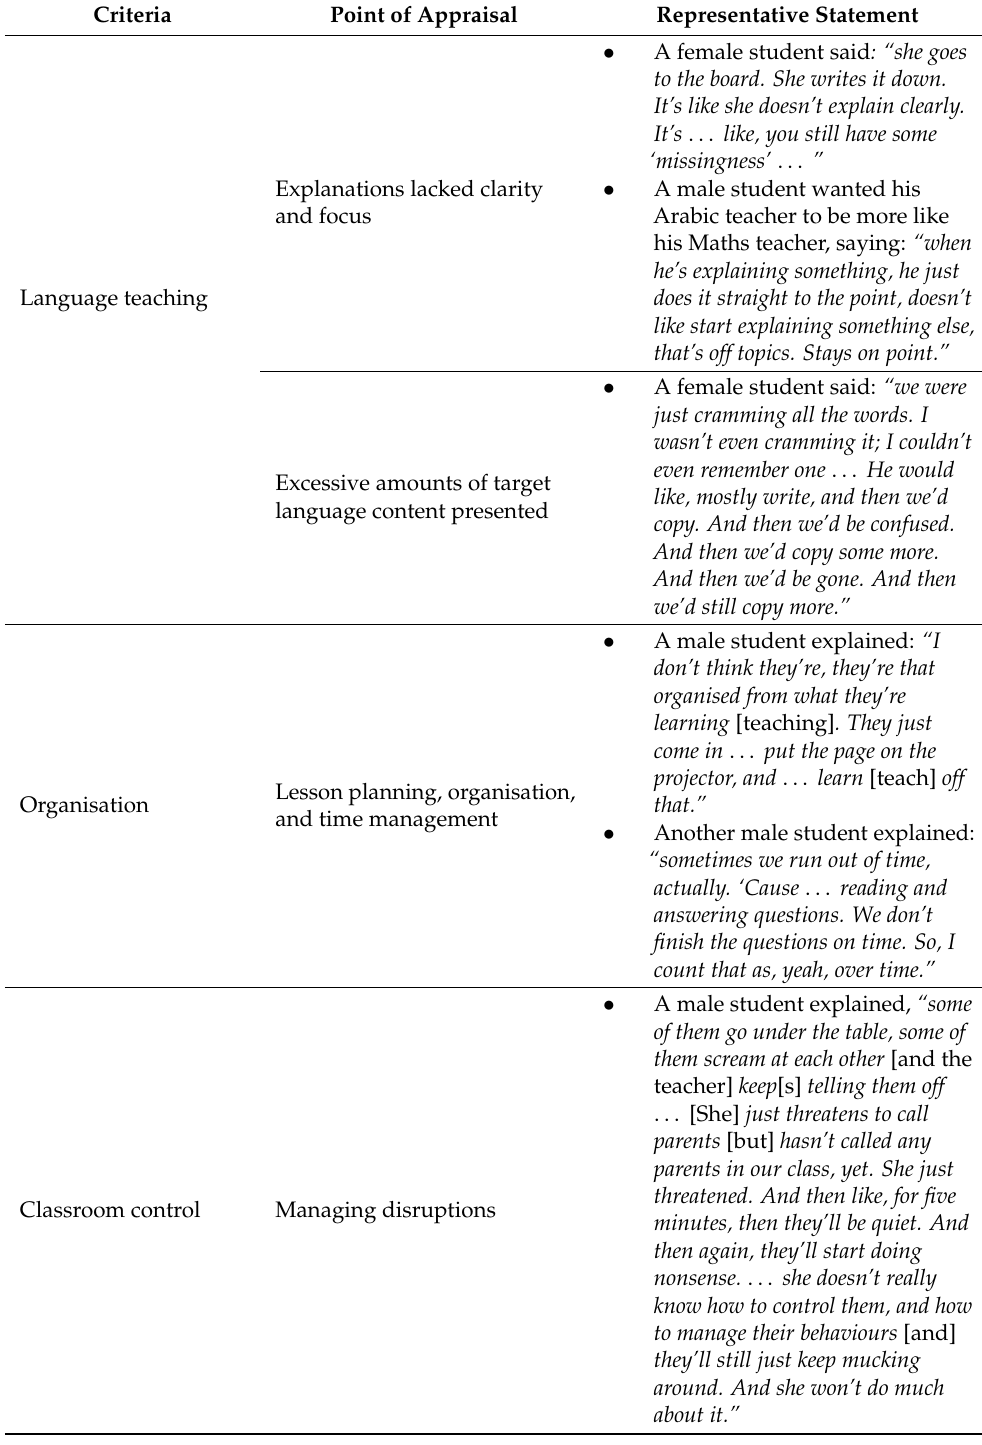
Table 2. Appraisal of